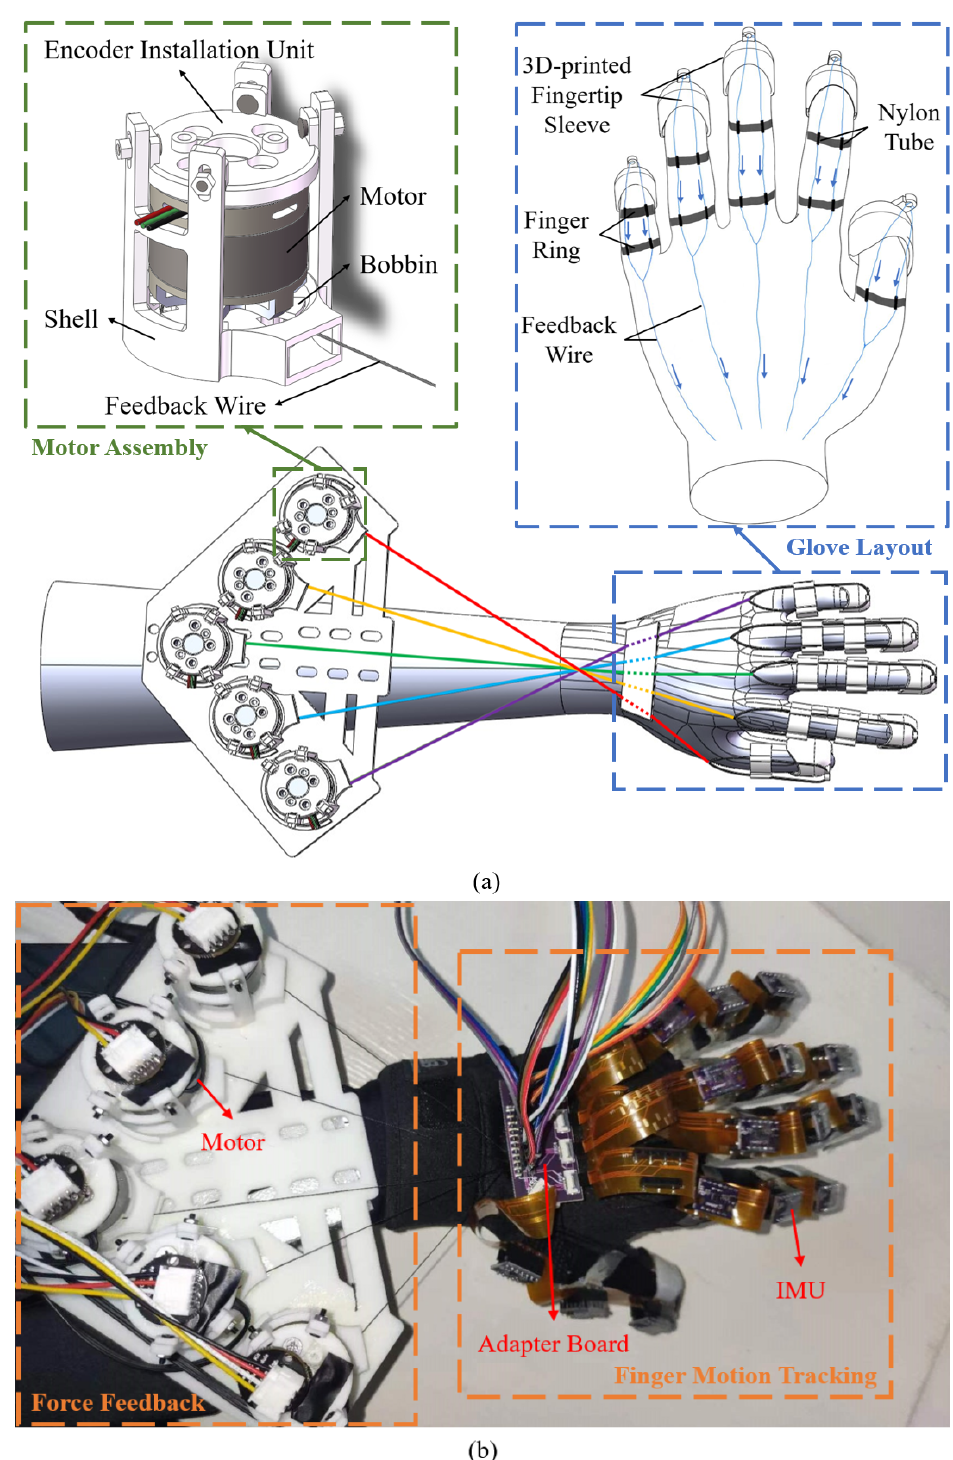
Figure 3. ( a ) 3D rendering of the force feedback assembly including motor assembly, glove layout, and component integration. ( b ) Prototype of the integrated soft robotic glove. The schematic layout of the feedback wires on the back of the glove is illustrated in the upper-right of Figure 3a. One end of a feedback wire is fixed to a 3D-printed fingertip sleeve. The wire then passes through the nylon tubes inside finger rings, which serve as anchor points. Note that the wire separates into two along the finger for better force balance. Two nylon tubes are sewn onto each finger ring, which is then glued on the